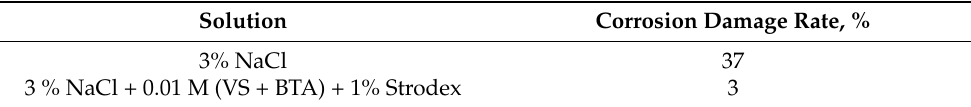
Table 6. The proportion of corroded steel surfaces after 12 h of exposure to 3% NaCl solution at T = 60 ◦ C and constant stirring of the solution.